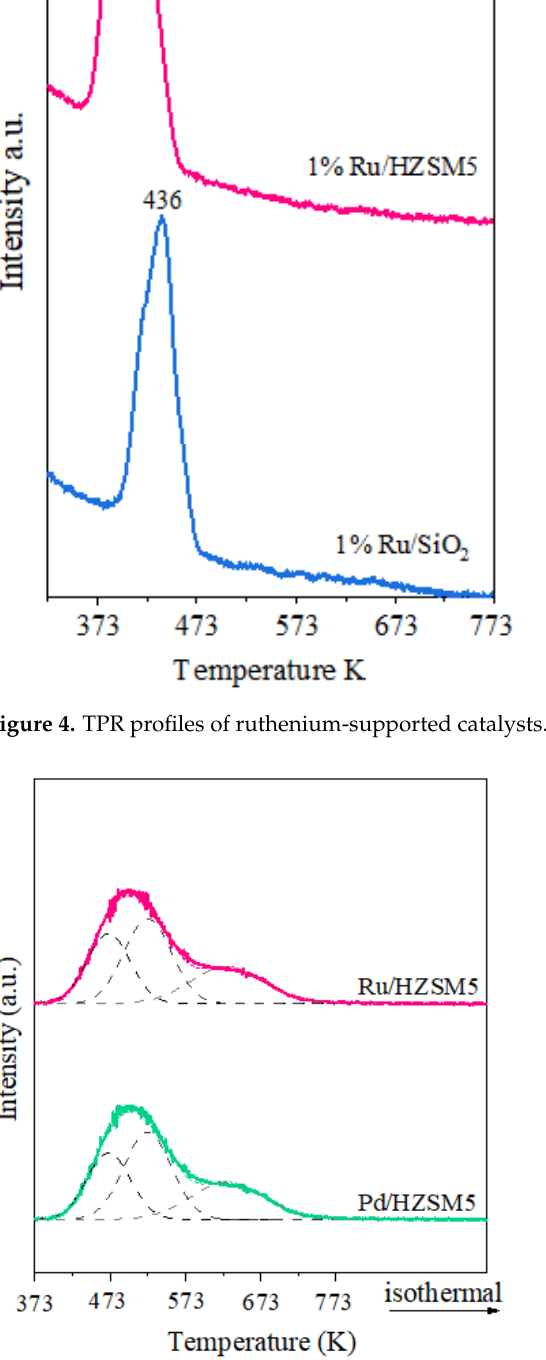
Figure 4. TPR profiles of ruthenium-supported catalysts.